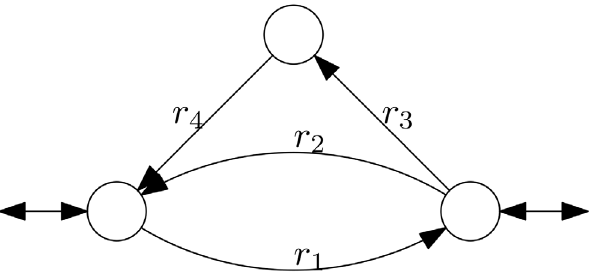
Fig 1. Toy network. Internal reactions r 1 , r 2 , r 3 , r 4 are irreversible. By thermodynamics, it is not possible to have non-zero flux through r 1 and also to have a non-zero flux through one of r 2 , r 3 or r 4 at the same time.